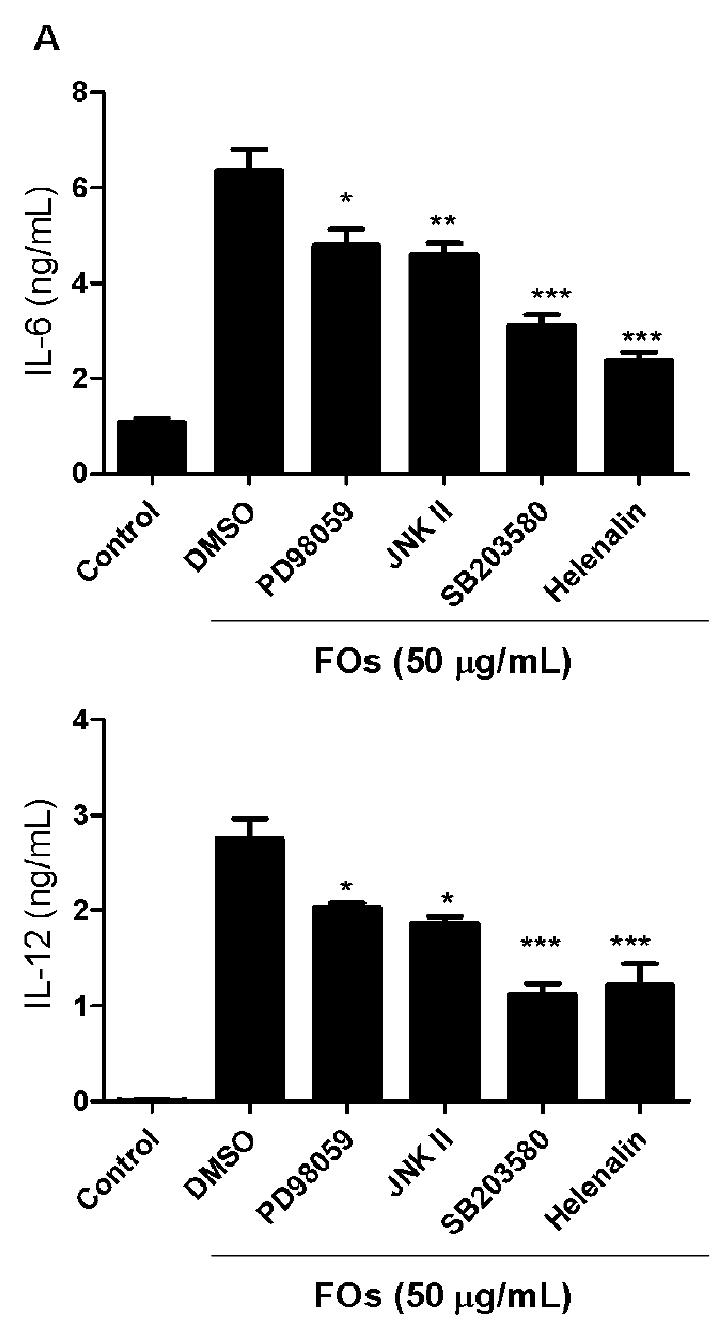
Figure 5. FOs-induced DC maturation was inhibited by PD98059, SB203580, JNK I, BAY 11-7082. Immature DCs were pre-treated with PD98058 (10 µM), JNK I (10 µM), SB203580 (10 µM), and BAY 11-7082 (10 µM) for 1 h before FOs treatment. ( A ) IL-12 cytokine and IL-6 production and ( B ) CD86 and ( C ) MHC class II expression were measured 24 h